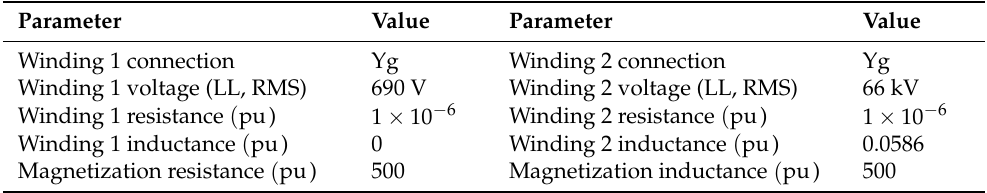
Table A2. Parameters of wind turbine transformers in the wind plants.